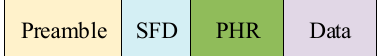
Figure 3. The frame structure of the physical layer. Figure 2. Decawave’s DWM1001 Development Board.